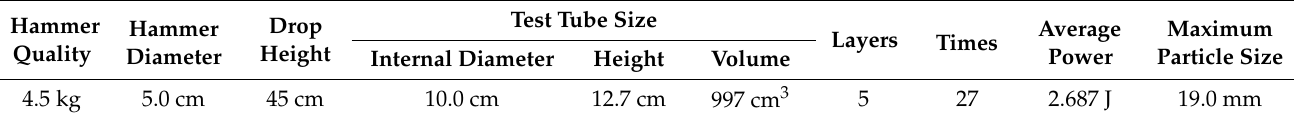
Table 6. Parameters of the compaction test.